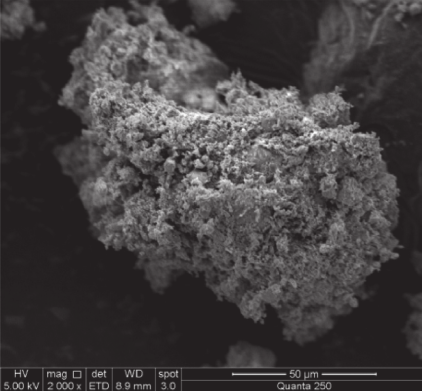
Figure 7: SEM image of the ZnO/sepiolite composite prepared by the impregnation-reduction